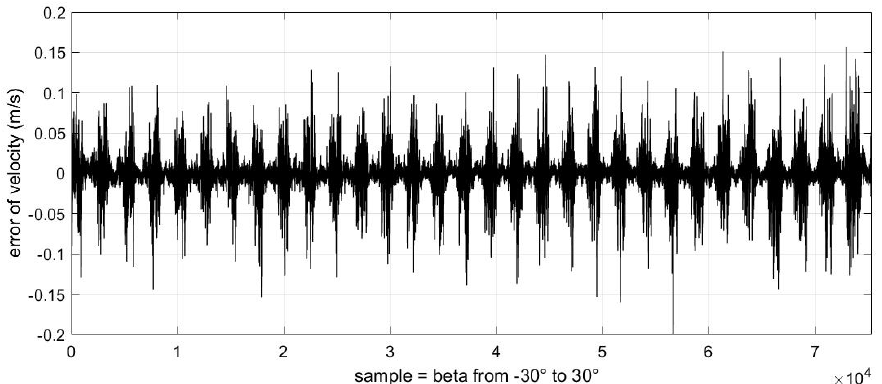
Figure 19. The relationship between velocity of incoming flow estimation error and sideslip angle